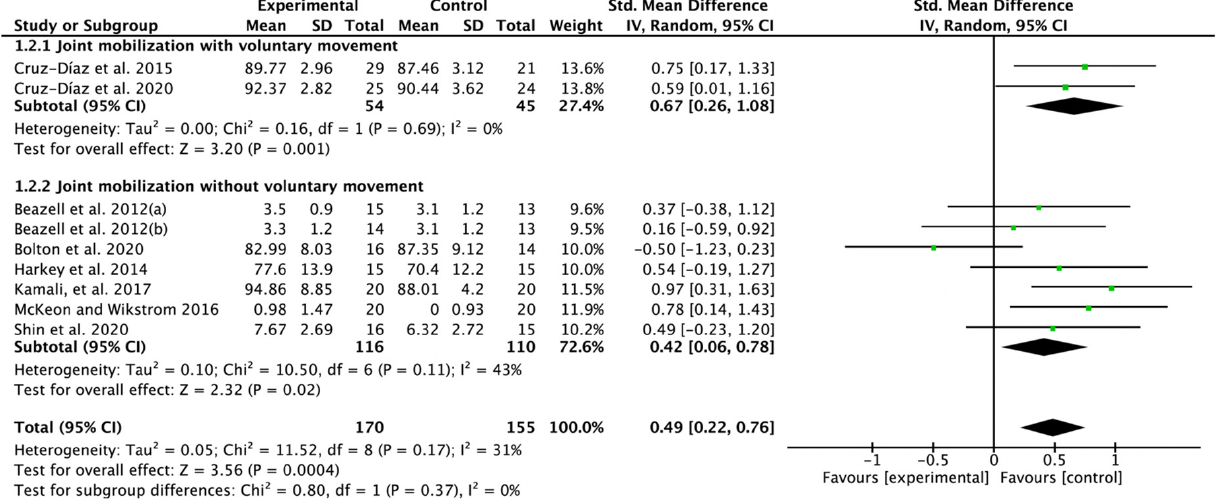
Figure 4. Forest plot on the effect of joint mobilization on dynamic balance. Beazell et al. 2012(a) [18], proximal tibiofibular joint mobilization; Beazell, et al. 2012(b) [18], distal tibiofibular joint mobilization. Cruz-D í az et al. 2015 [19], Cruz-D í az et al. 2020 [17], Bolton et al. 2020 [23], Harkey et al. 2014 [25], McKeon and Wikstrom 2016 [21], Shin et al. 2020 [20], Kamali et al. [24].